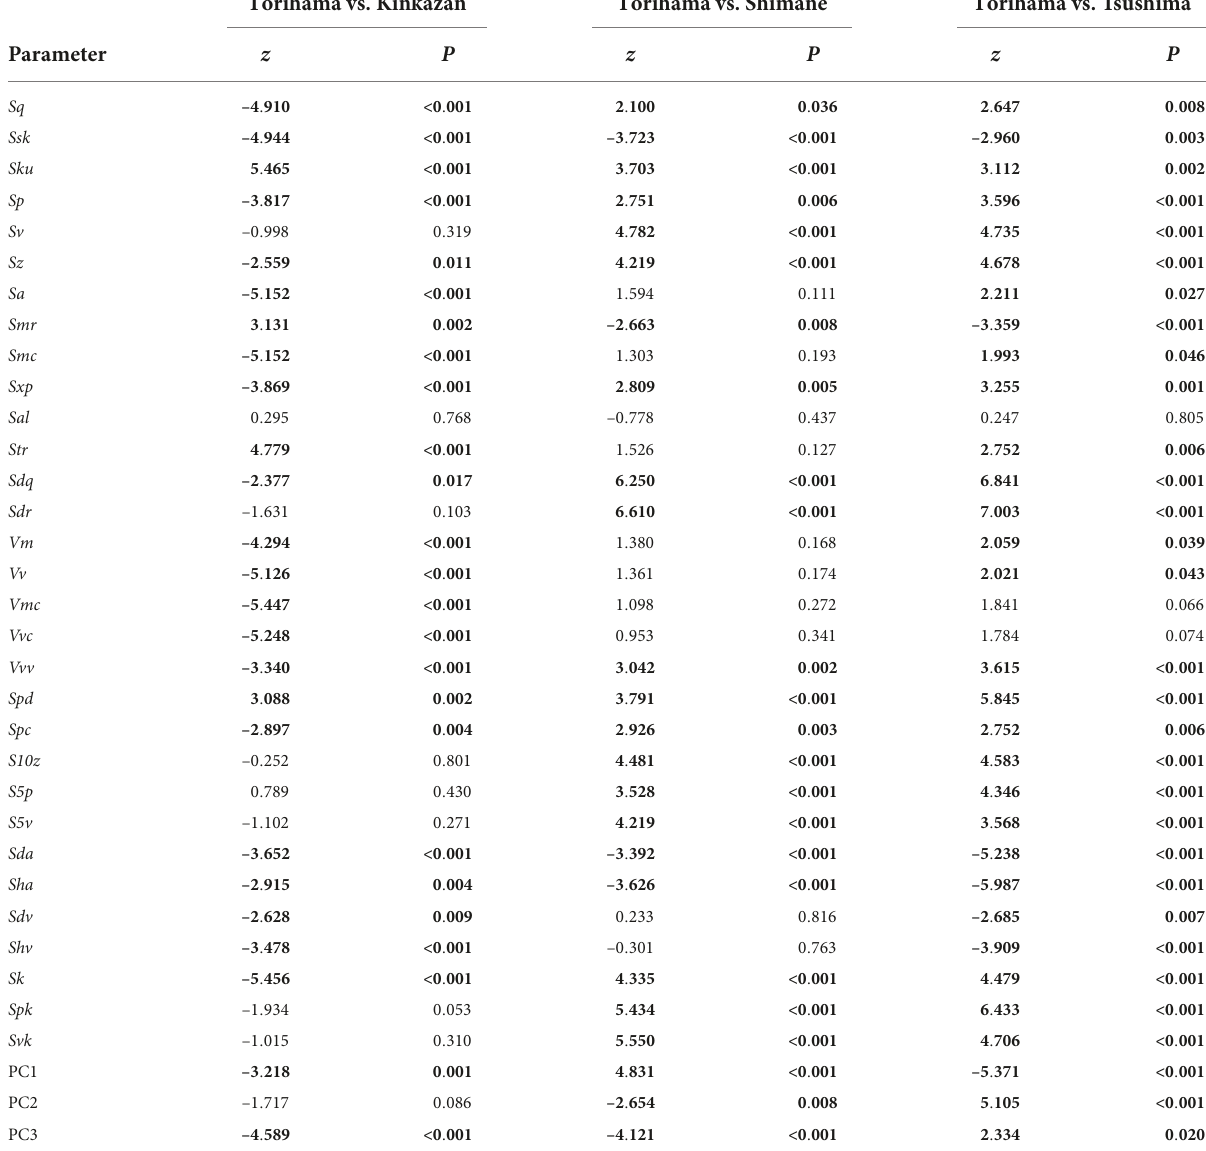
TABLE 4 Comparison of DMT parameters and principal component scores between Torihama deer and extant